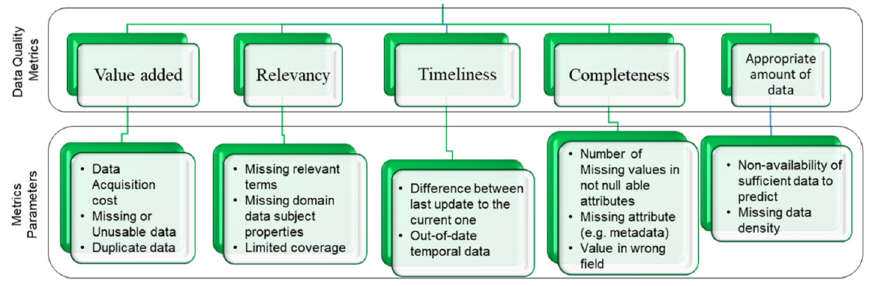
Figure 6. Contextual data quality metric parameters.